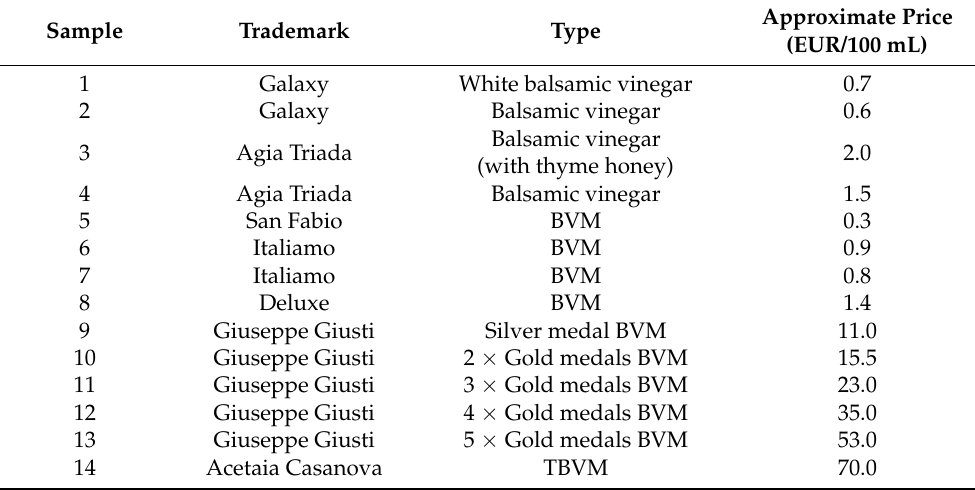
Table 1. Balsamic vinegar samples (1–4 Greek balsamic vinegars, 5–8 balsamic vinegars of